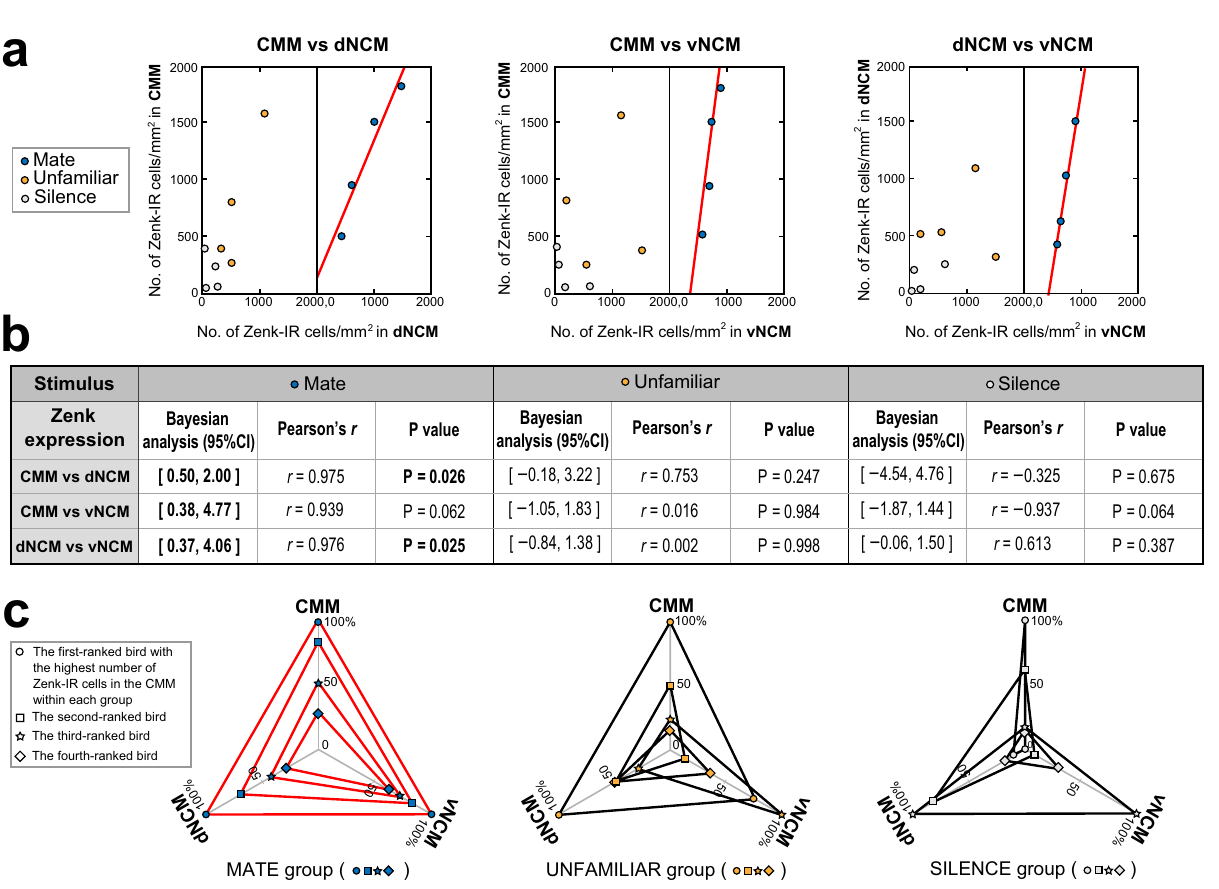
Figure 4. Analysis of correlations in Zenk expression between subregions of the caudomedial pallium after CC stimulation. ( a ) Scatterplots of number of Zenk-IR cells per square millimetre activated in response to mate CCs (right side of each figure), or unfamiliar CCs, or silence (left side of each figure) are plotted for individual subjects. Shown are correlations in CMM versus dNCM (left), CMM versus vNCM (centre), and dNCM versus vNCM (right). There were three significant linear relationships between subregions with Bayesian analysis, where linear regression lines in red are fitted. ( b ) The statistics of the data in ( a ) are given in the table with CIs of Bayesian analysis, correlation coefficients ( r ) and P values of Pearson’s correlation analysis. Statistically significant values are highlighted. ( c ) Shown are patterns of correlation across subregions of the number of Zenk-IR cells activated in response to mate CC (left), unfamiliar CC (centre), or silence (right). Within a group, the expressions were scaled to the data of the bird with the highest Zenk expression in each of the three subregions, and the CMM, dNCM, and vNCM values for the same subject are plotted as percentages and connected with lines. The values of the first-ranked bird in the CMM within each group are indicated by circles in the figure. The values of the second-, third-, and fourth-ranked bird in the CMM within each group are indicated by squares, stars, and diamonds, respectively. The types of stimuli are color-coded as in ( a ). Note that only in the case of mate CC (left) was a well-organised and ordered ’triangle’ relationship observed within the group. In the other cases, i.e., unfamiliar CC (centre) or silence (right), these triangles overlap irregularly or do not form. Inter-subregion lines drawn in red indicate significant linear relationships between subregions with Bayesian